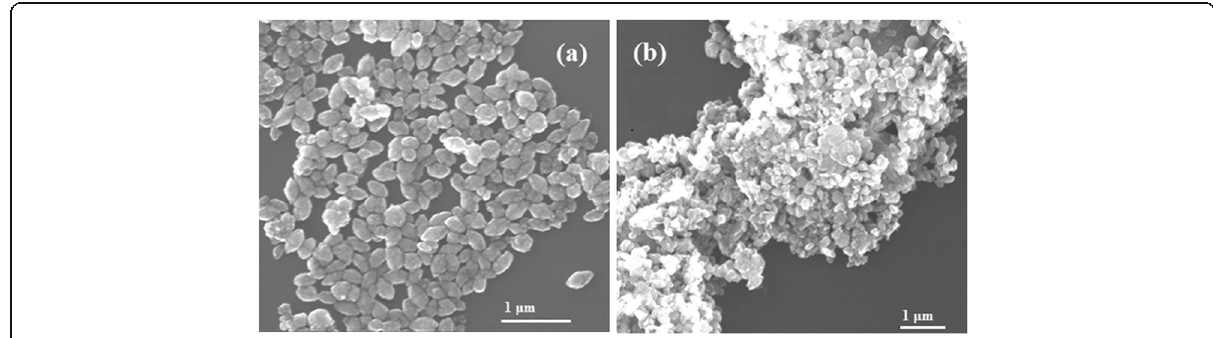
Fig. 3 SEM images of ZnO samples under various conditions of ( a ) 0.015 M, 5 mL, and 170 °C and ( b ) 0.05 M, 5 mL, and 170 °C